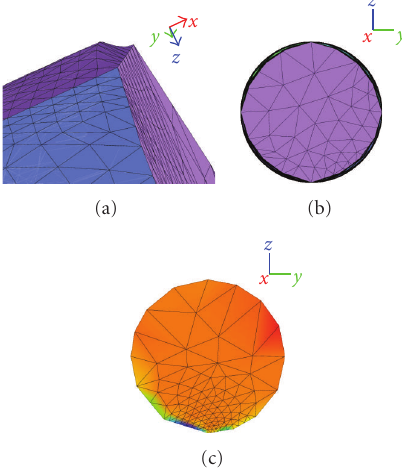
Figure 4: Projection to the wrong surface for segments on the intersection between patches. (a) Detail of the channel exit with a false step created. (b) Front view of the channel exit. (c) Relative solution with erroneous results due to wrong placement of new nodes.